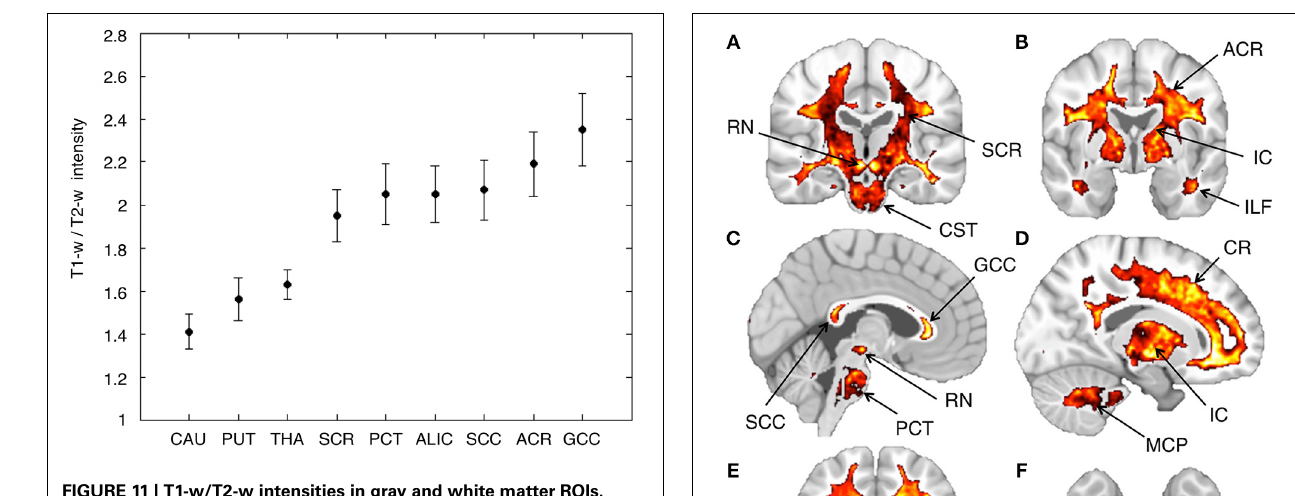
FIGURE 11 | T1-w/T2-w intensities in gray and white matter ROIs. Average and standard deviation of T1-w/T2-w values are shown for the nine selected ROIs, three in the gray matter, and six in the white matter. As expected, T1-w/T2-w values were lower in the gray matter and in the white matter. The ROIs are labeled as follows: caudate nucleus (CAU), putamen (PUT), thalamus (THA), superior corona radiata (SCR), pontine crossing tract (PCT), anterior limb of internal capsule (ALIC), splenium of corpus callosum (SCC), anterior corona radiata (ACR), and genu of corpus callosum (GCC).